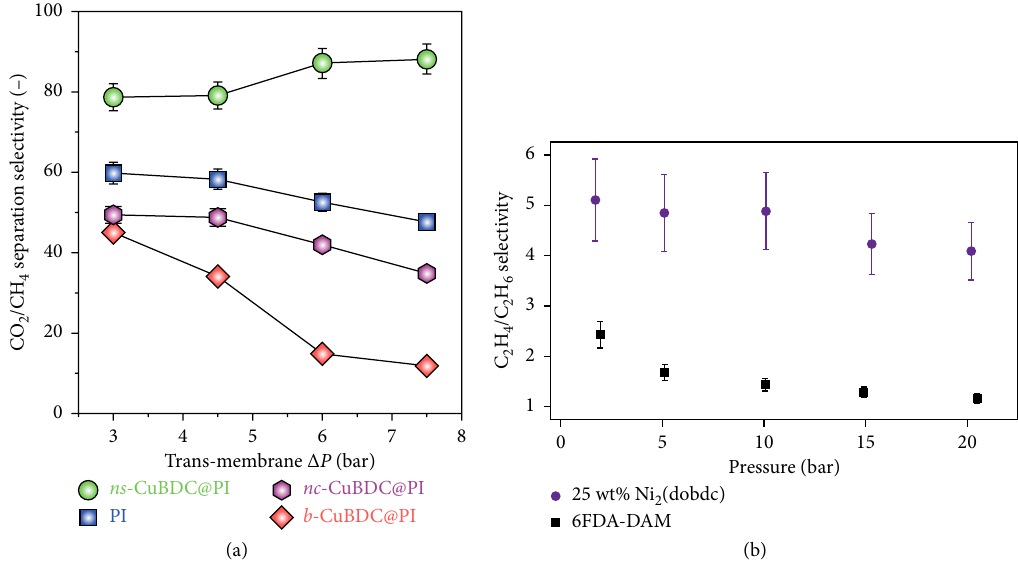
Figure 5: (a) Difference of separation selectivity of CO (b) Selectivity of C